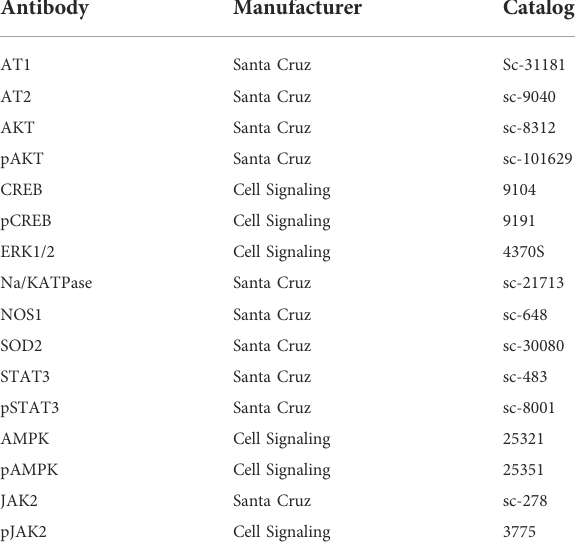
TABLE 2 List of antibodies used manufacturer and catalog